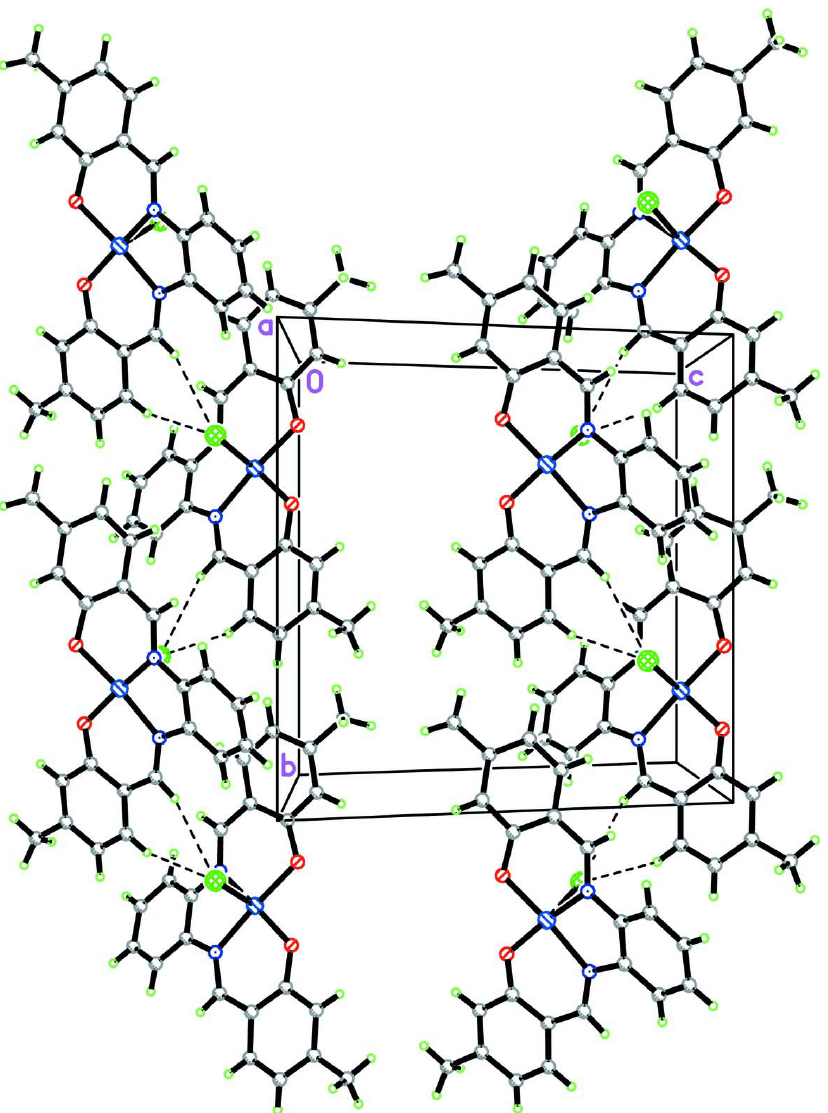
The crystal packing of (I), viewed along the a axis, showing the three-dimensional network. C—H···Cl weak interactions are drawn as dashed